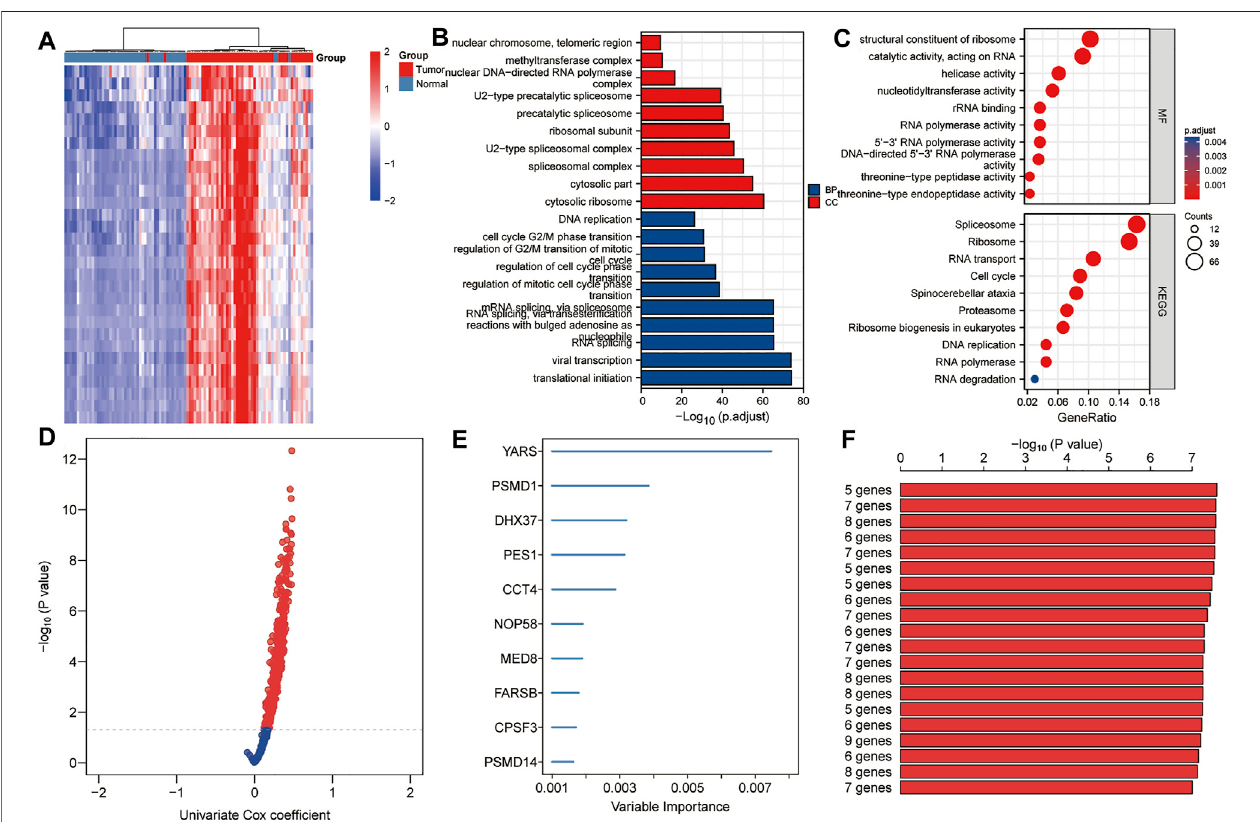
FIGURE2| EstablishmentofprognosticgenemarkersrelatedtocancercellproliferationinHCC. (A) Heatmapshowingsigni fi cantlyDEGsinHCCrelatedtocancer cell proliferation. Using the RNA sequencing data of the TCGA HCC cohort and the CRISPR Library, 640 DEGs related to proliferation in HCC were screened out (| log2FC| > 1 and FDR < 0.05). (B,C) GO and KEGG analysis revealed important biological processes, cell components and KEGG pathways enriched by 640 DEGs. (D) Using univariate Cox analysis, candidates related to prognosis were identi fi ed ( p < 0.05). (E) Using random forest, the top 10 most characteristic genes are screened out. (F) A combination with a relatively small number of genes and a relatively signi fi cant p value was selected to construct a survival prediction model from a variety of combinations of 10 genes. DEGs, differentially expressed genes; FDR, false discovery rate; BP, biological processes; CC, cell components; MF, molecular